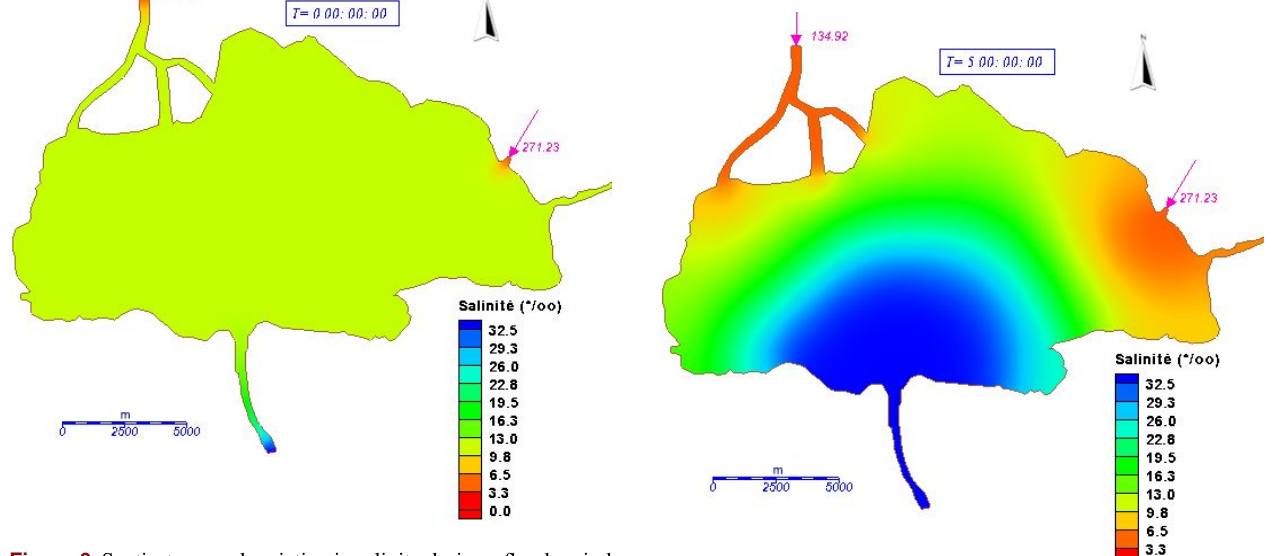
Figure 6. Spatio-temporal variation in salinity during a flood period at the start of the simulation.